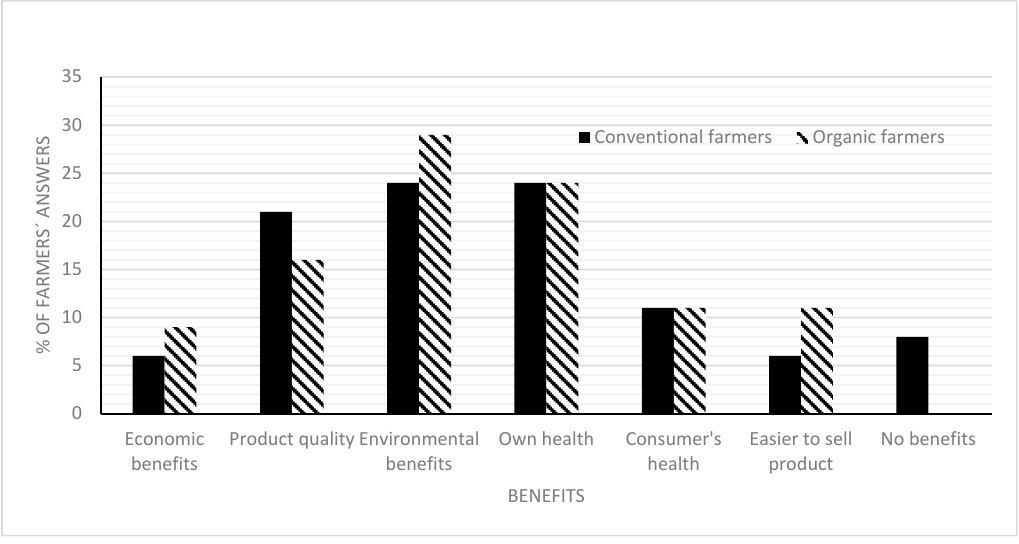
Figure 2. Benefits of organic farming as perceived (open-ended question) by organic ( n = 16) and conventional ( n = 23) olive farmers in in Messenia, Greece.